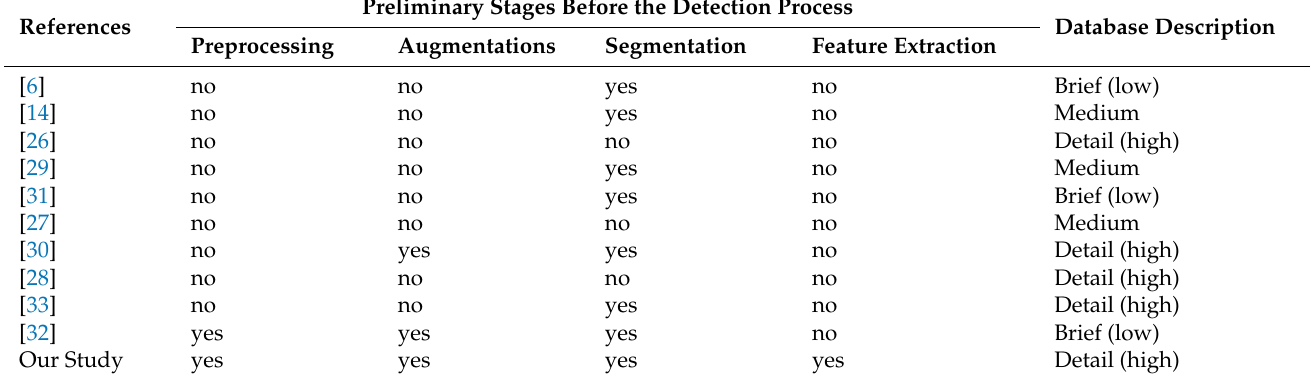
Table 4. Comparison of existing related survey papers.